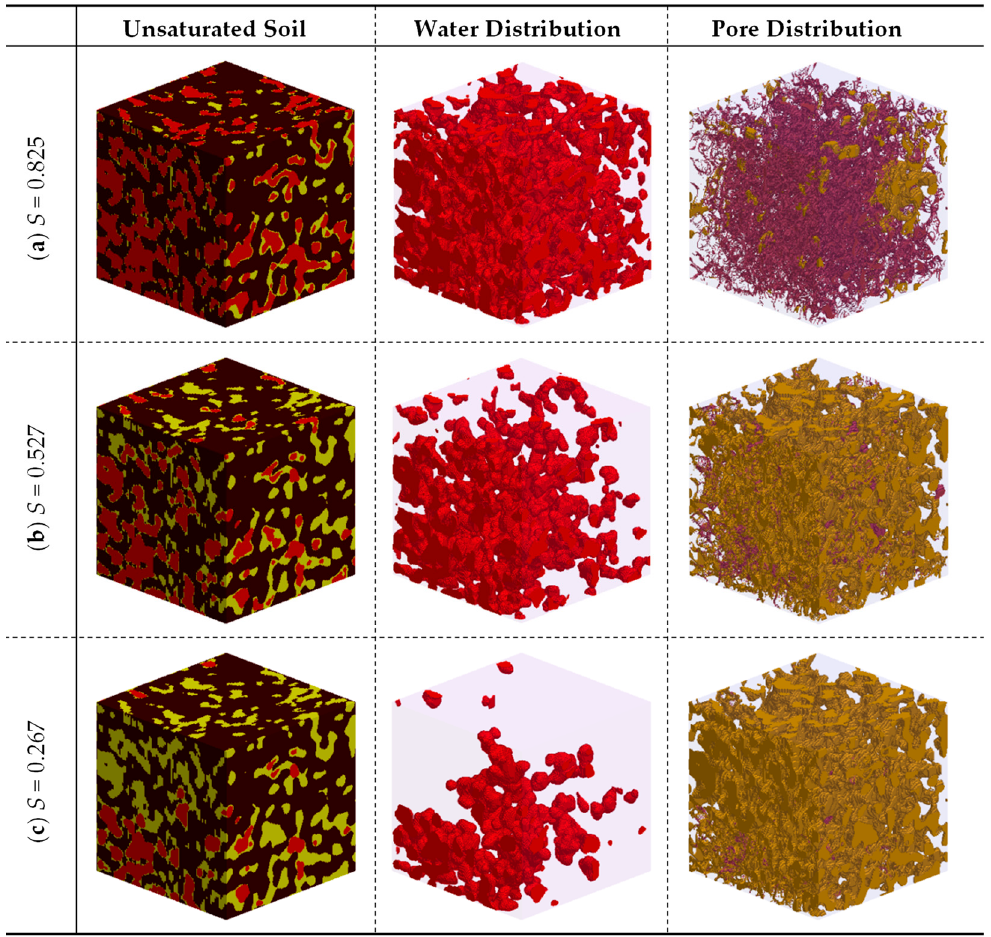
Figure 2. Image illustrations of water and pore distributions in the soil (sample 1) under different water saturations S , The left column images show the solid (brown), water (red) and pore (yellow) distributions; the middle column images show the water distribution (red); the right column images show the connected pores (yellow) and unconnected pores (purple): ( a ) S = 0.825; ( b ) S = 0.527; ( c ) S = 0.267.